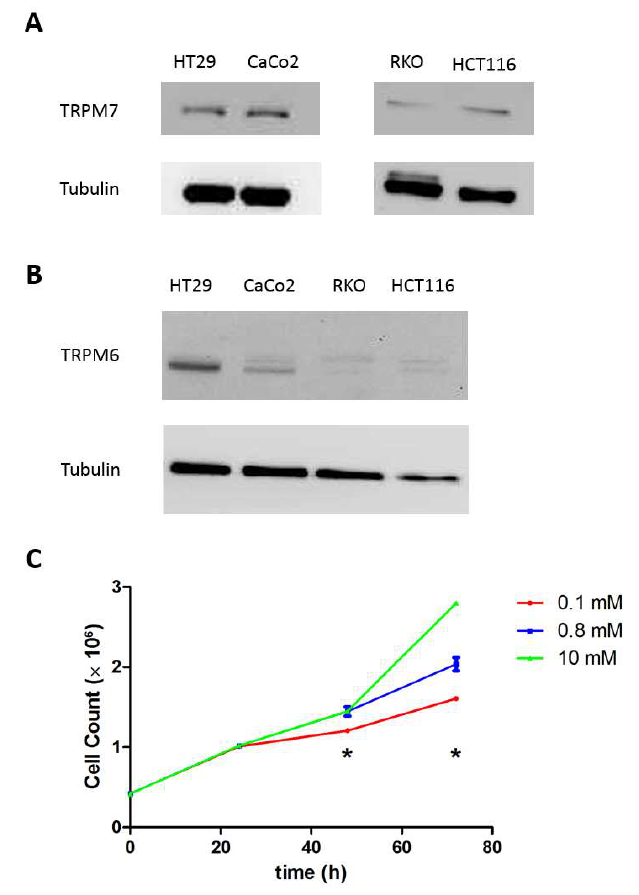
Figure 1. Human colon cells express both transient receptor potential melastatin type TRPM6 and TRPM7 and depend on extracellular Mg availability for growing. A representative Western blot ( n = 3) is shown for ( A ) TRPM7 and ( B ) TRPM6 in a panel of human colon cell lines. Tubulin was used as a loading control. ( C ) HT29 cell proliferation in conditions of low (0.1 mM), normal (0.8 mM) and high